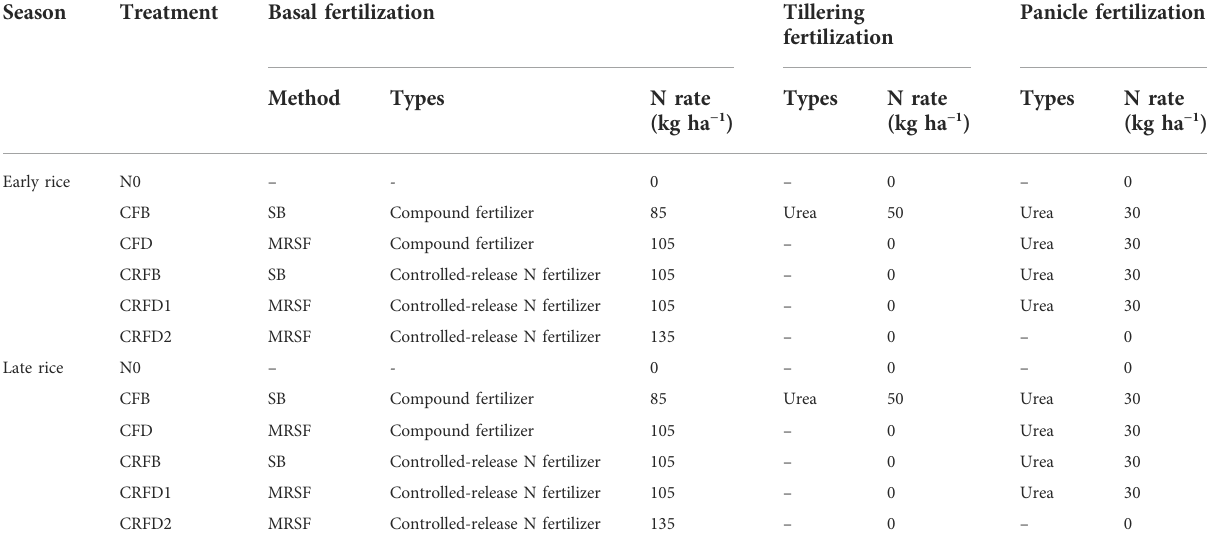
TABLE 1 The experimental design and nitrogen fertilizer management.